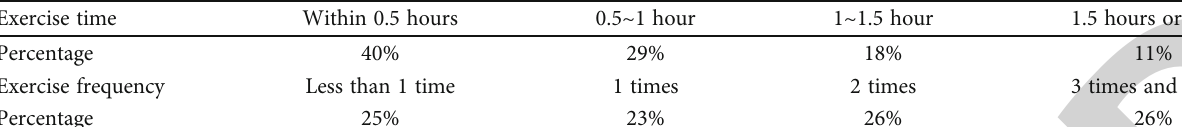
Table 2: Physical exercise time and frequency of college students.